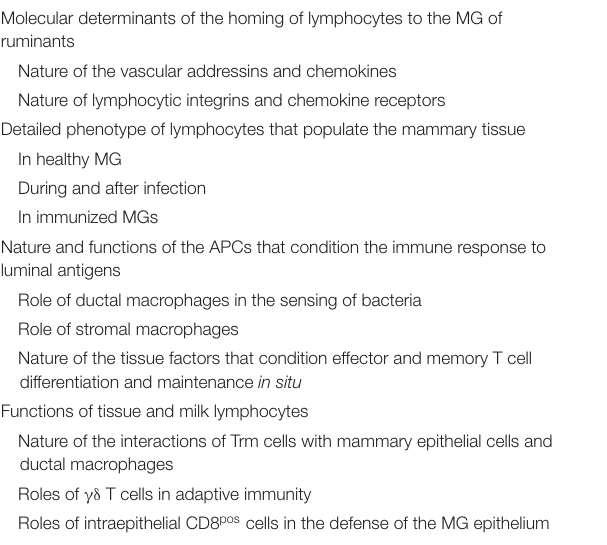
TABLE 2 | Knowledge gaps that hinder the design of efficacious mastitis